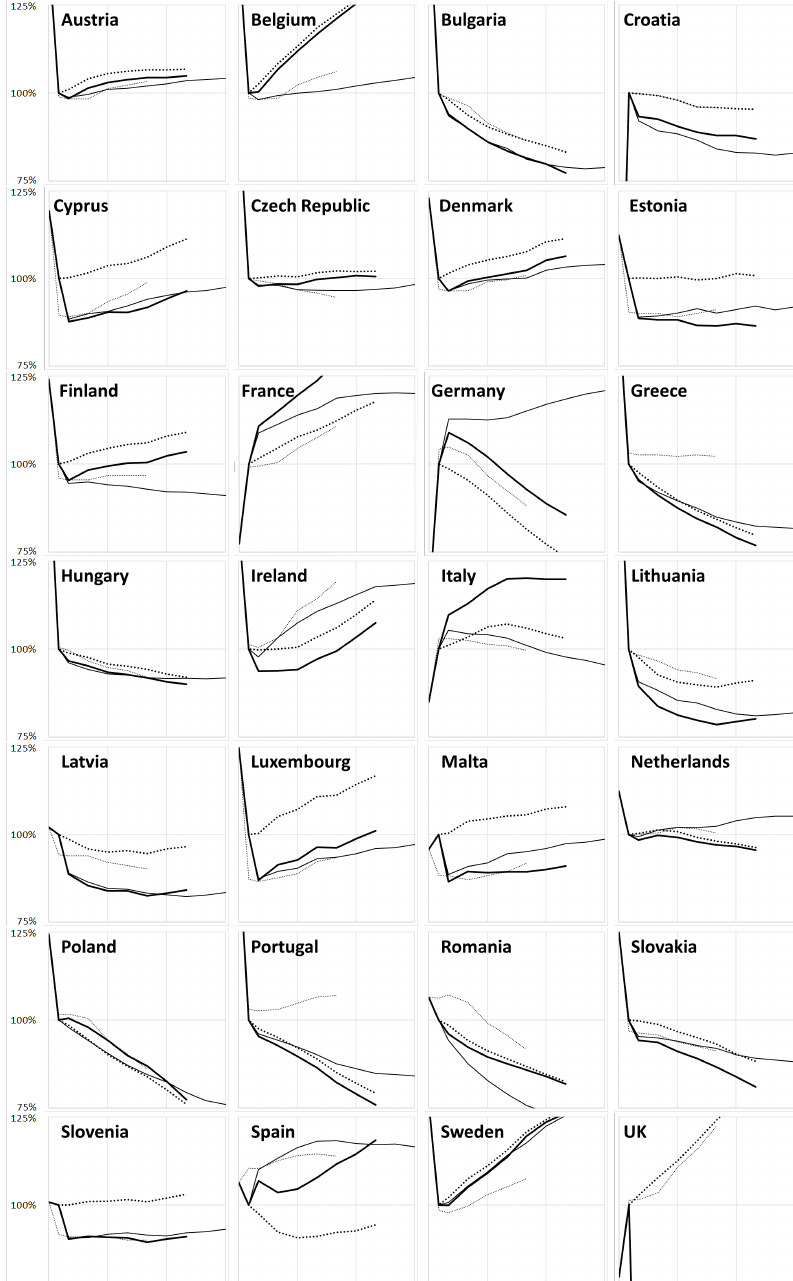
Figure A1. Shapley–Shubik index forecasts per country. Dotted lines show 2010 [6] and 2014 pre- Brexit (thick, Table A1), solid Brexit 2014 (thick, Table A3), 2020 (thin, Table A4). The two thick lines directly compare the Brexit/no-Brexit forecasts from around the time of the Brexit